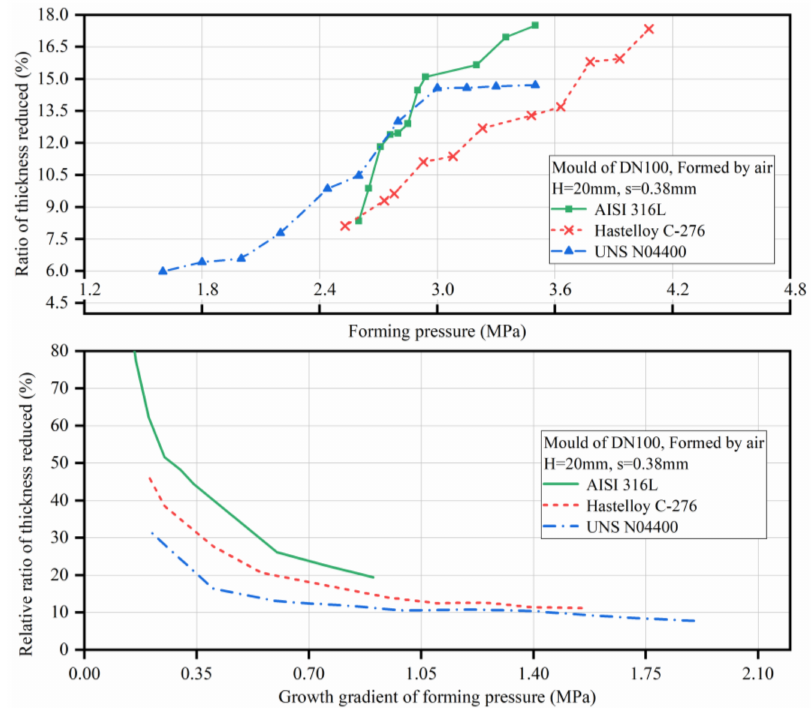
Figure 19. Absolute and relative ratios of thickness reduction for Dn 100 mm rupture discs with different